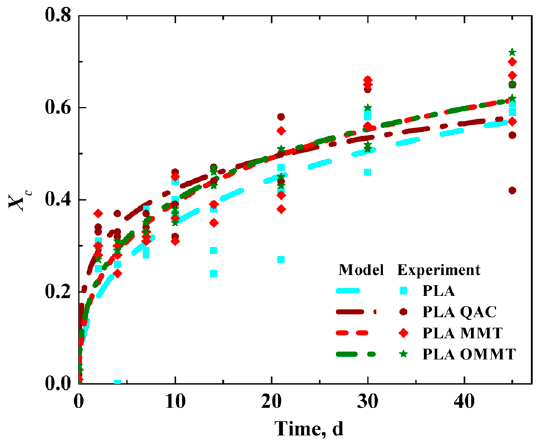
Figure 3. Crystalline fraction of PLA, PLA QAC, PLA MMT and PLA OMMT during hydrolytic degradation at 60 °C. Fitted lines were estimated from the Avrami equation, X t = 1 − exp[ − ( k c t ) n c ], where X t is the time-dependent fraction of crystallinity, k c is the Avrami constant, t is the hydrolysis time and n c is the Avrami